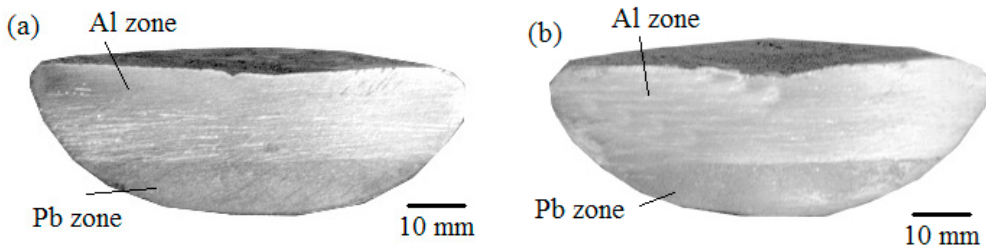
Figure 2. Ingots of Al–50%Pb alloys: ( a ) without treatment; ( b ) ingot after EMP processing.